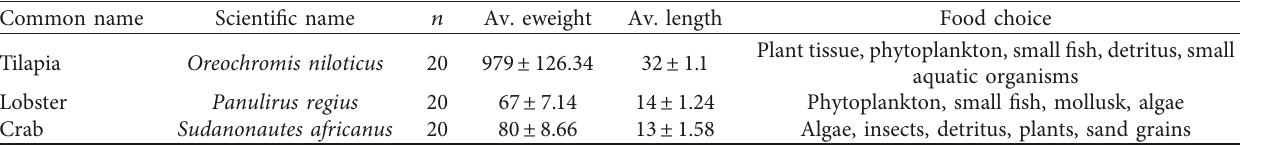
Table 1: Information on the diet of the three seafoods.